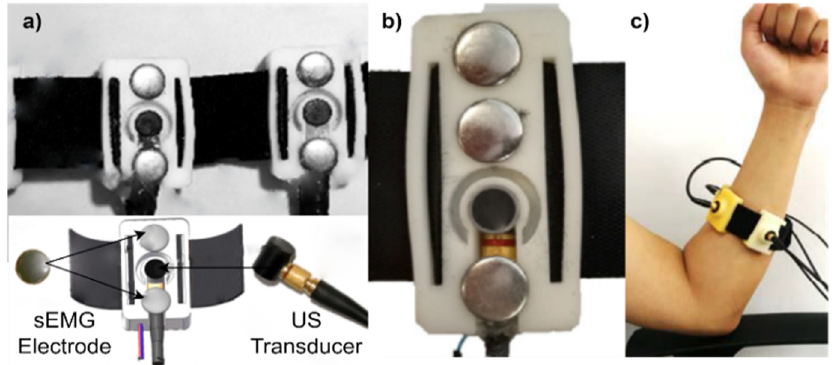
Figure 3. Adapted photographs of wearable systems using ultrasound and sEMG: ( a ) hybrid armband supporting sEMG electrodes and US transducer, developed by authors [62]; ( b ) sensory module integrating US transducer in the black area and sEMG electrodes within gray area, where the reference electrode is on the top, designed by [63]; and ( c ) four-channel A-Mode ultrasound armband, adapted by the group [56].